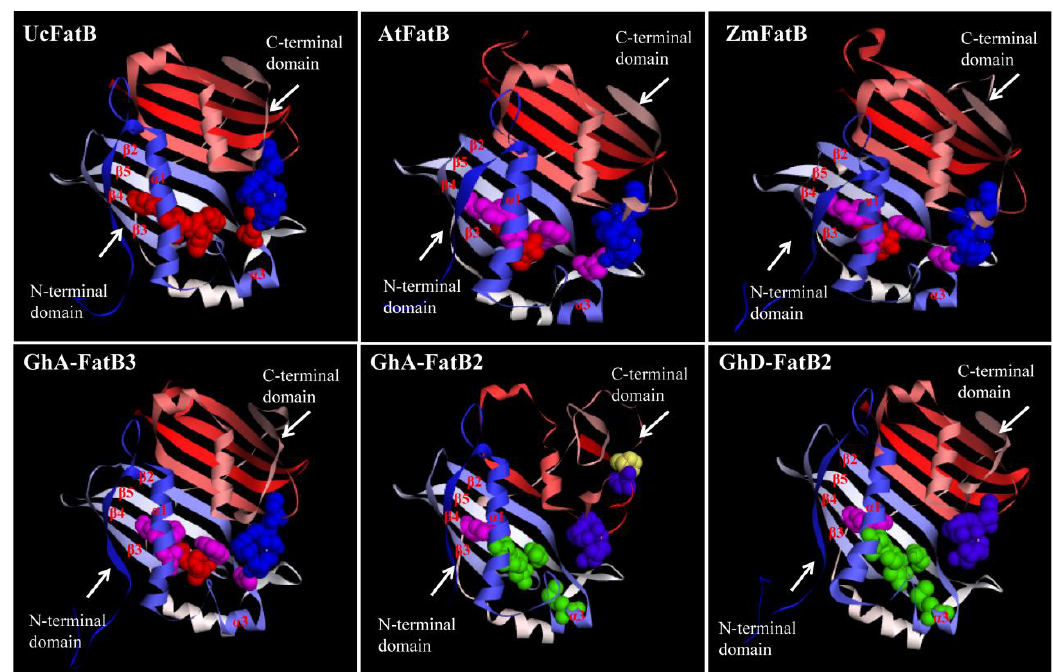
Figure 3. Three-dimensional structure models of GhFatB protein monomers. All 3D structures were predicted on Swiss-Model (https://swissmodel.expasy.org/) (accessed on 12 October 2021) with UcFatB (AAA34215.1) as the template. Files of 3D structure of GhFatBs were displayed in Discovery Studio 4.1 software. Blue bolls show the AAs affect enzyme activities in the C-terminal domain, whereas yellow bolls represent the varied AAs different from that of UcFatB. Red bolls represent the AAs as being the same as the UcFatB in N-terminal domain. Pink bolls show the variant AAs different from UcFatB while green bolls show the additional residues different from UcFatB, AtFatB, and ZmFatB in the domain. Table 2. Key amino acids in the functional domain of various GhFatBs based on sequence alignment.